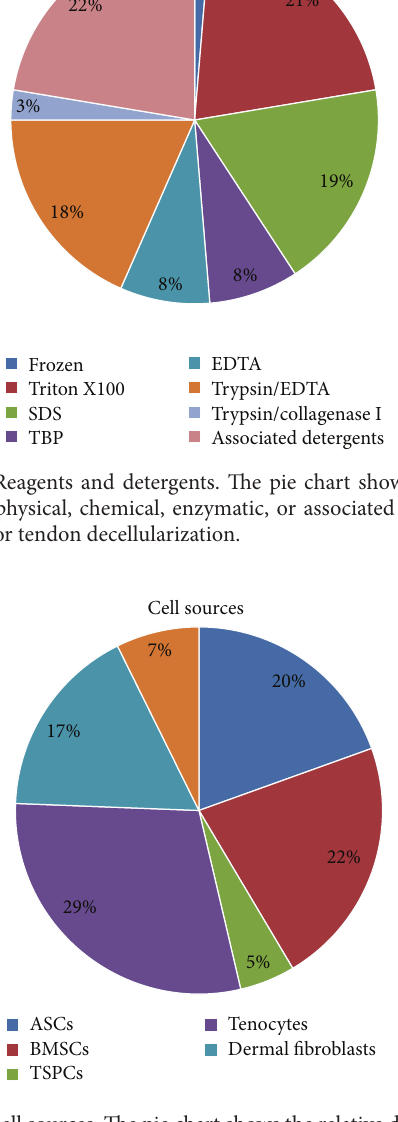
Figure 5: Cell sources. The pie chart shows the relative distribution of cell sources used to reseed the decellularized